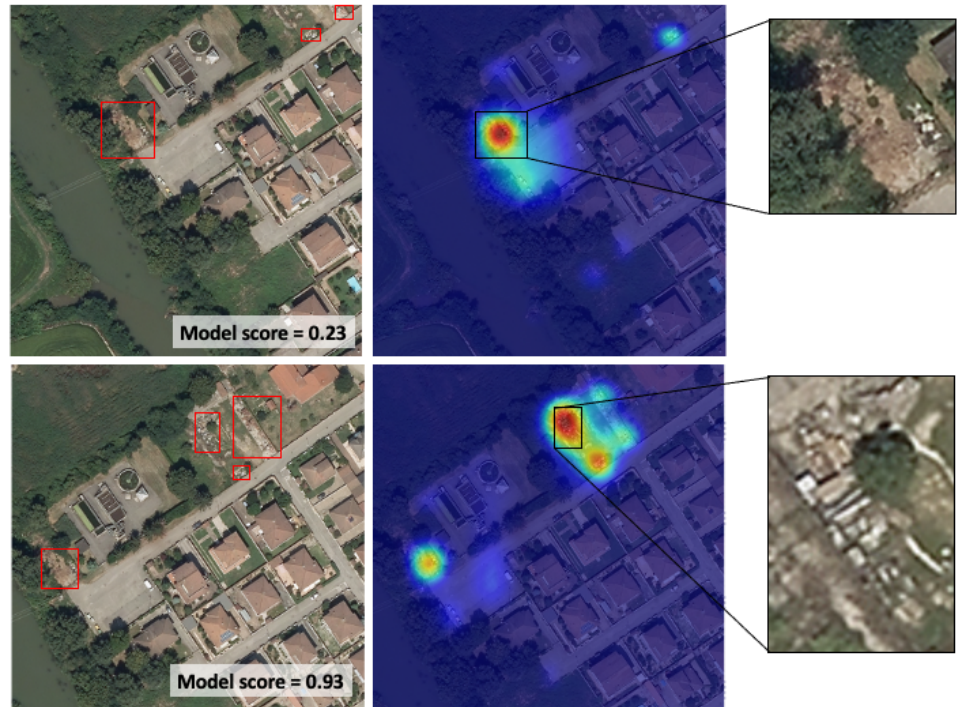
Figure 9. Example of a false negative caused by the fragmentation of the relevant scene across multiple tiles ( top ). A manually created image of the same scene that includes the missing information is classified positively ( bottom